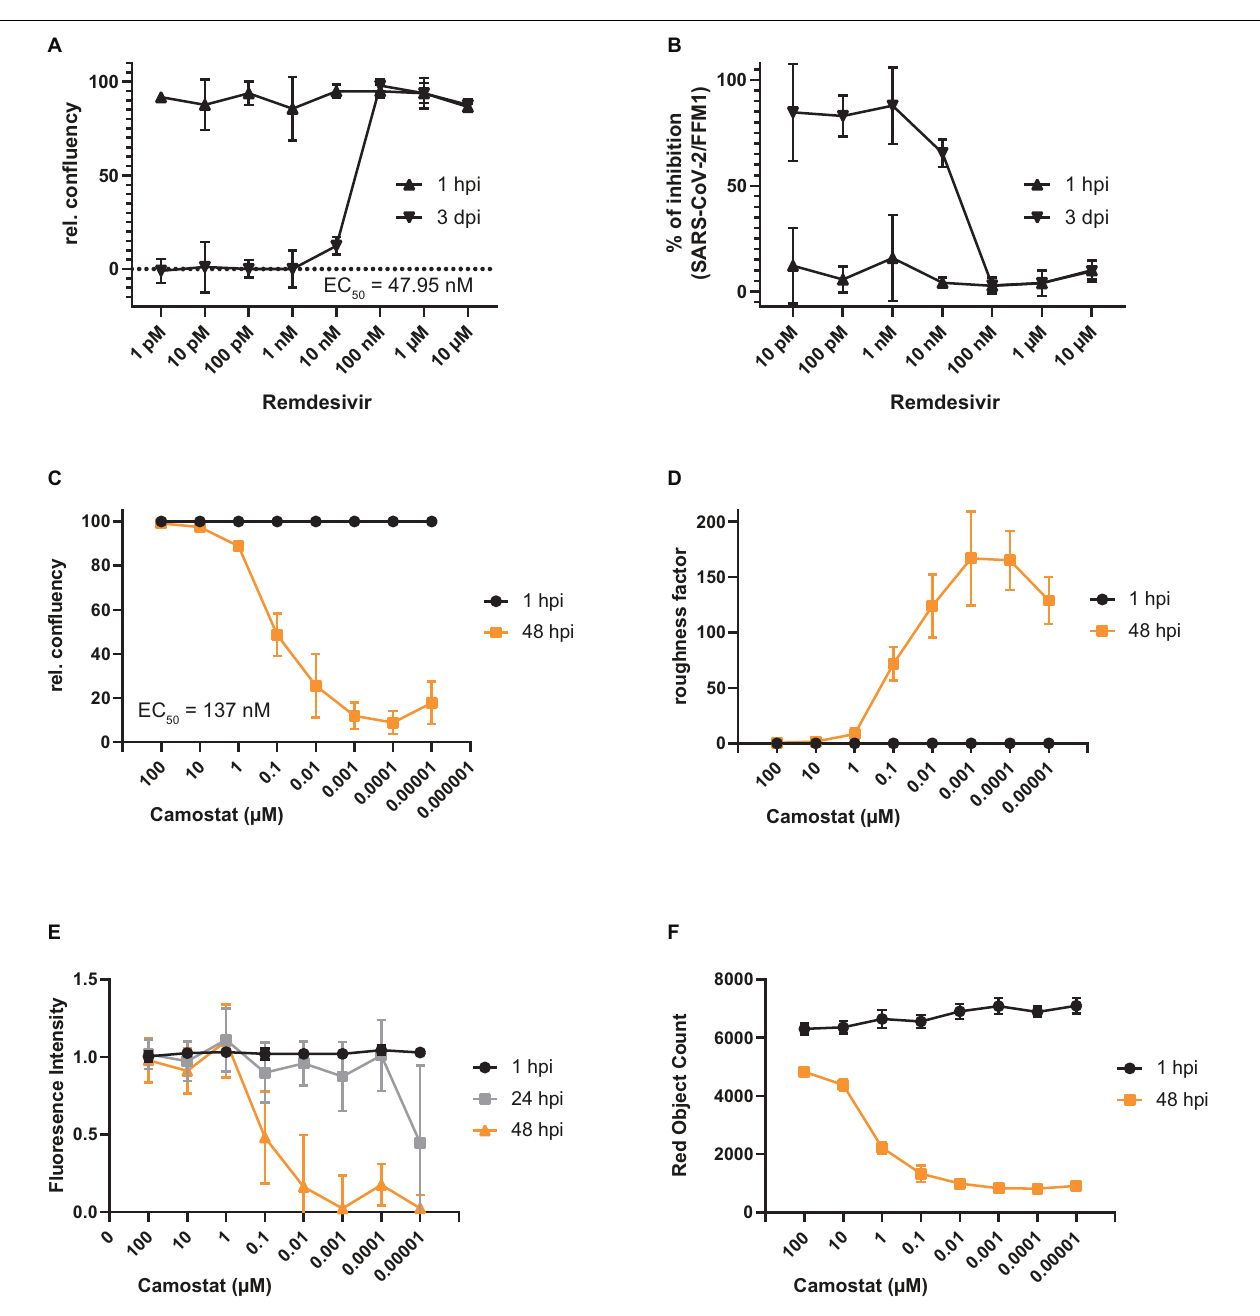
FIGURE 6 | Antiviral activity of remdesivir and camostat against SARS-CoV-2 using A549-AT cells. (A–F) Evaluation of antiviral activity of remdesivir ( n = 3) and camostat ( n = 6) against SARS-CoV-2 (1, 3, 24, or 48 h post infection as indicated). Relative confluency (A,C) and roughness (B,D) were measured as surrogate marker to monitor for SARS-CoV-2 induced CPE formation. Prior to infection, cells were treated with the indicated concentrations of remdesivir and camostat, respectively. (E) Relative fluorescence intensity (RFI) and (F) red object count (ROC) were determined alternatively to confluency and roughness. Error bars indicate standard deviation from at least three biological